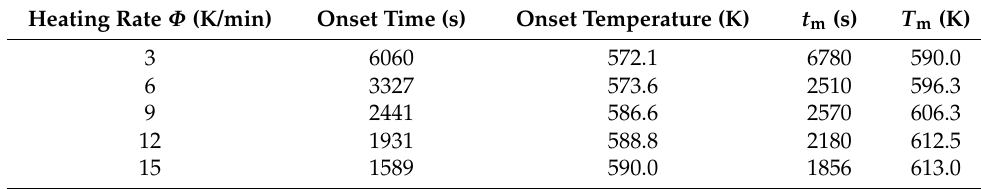
Table 1. Variations, with heating rate Φ , in the onset time, onset temperature, and time t m and temperature T m at which the d H d /d t has the maximum value under 1.0 bar H 2 for hydrided Mg–5Ni. Heating Rate Φ (K/min)